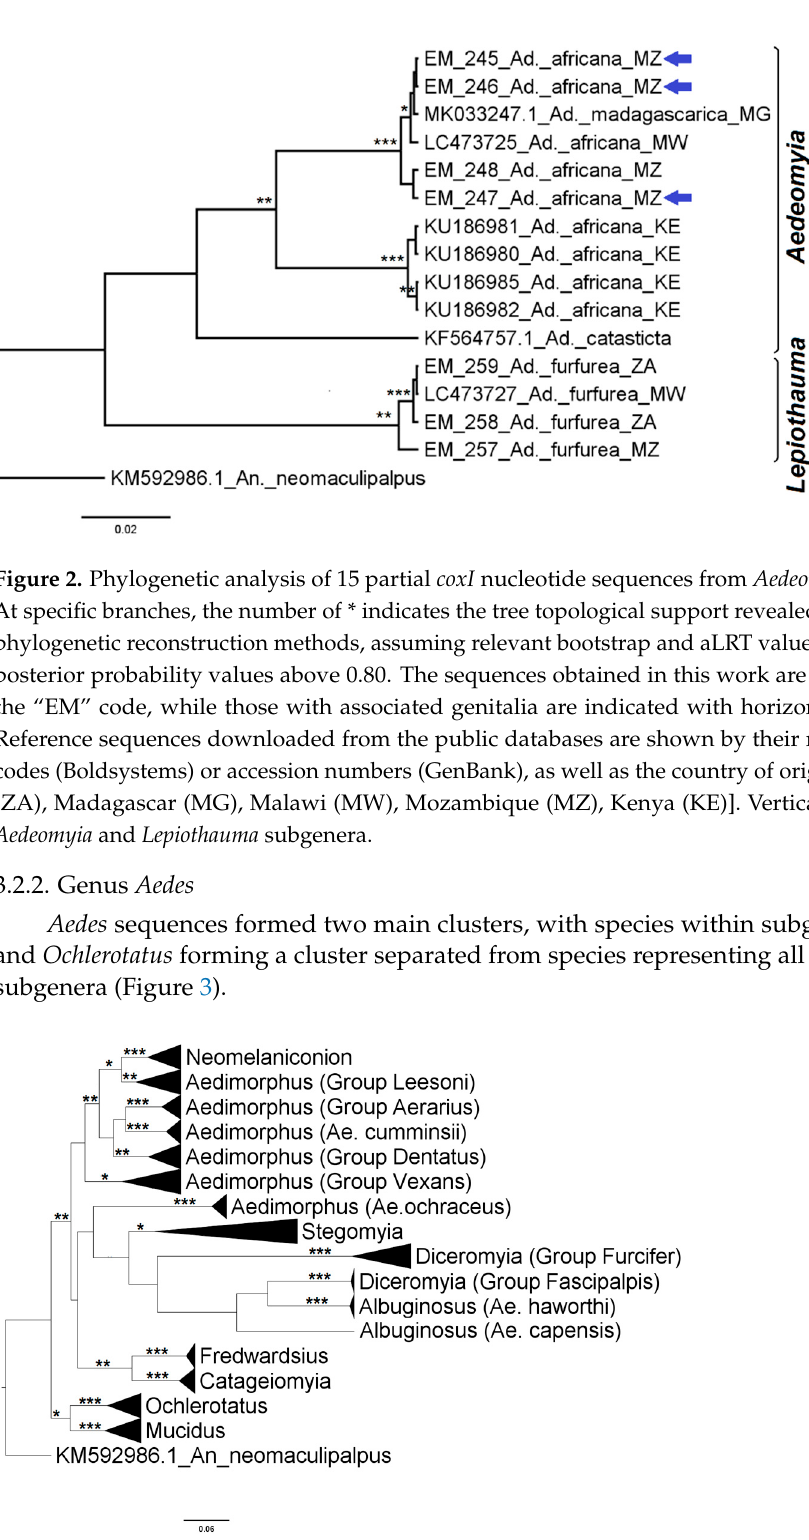
Figure 3. Phylogenetic analysis of 172 partial coxI nucleotide sequences from Aedes mosquitoes. At specific branches, the number of * indicates the tree topological support revealed by the different phylogenetic reconstruction methods, assuming relevant bootstrap and aLRT values above 75% and posterior probability values above 0.80. In the collapsed branches are the species of the subgenera and/or informal groups of the